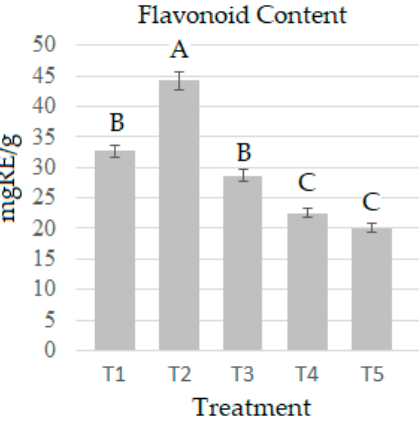
Figure 4. Flavonoid content in P. djamor over the five treatments. The bars indicate the mean of each experiment in triplicate with SE. Different letters indicate significant difference (T-Student p ≤